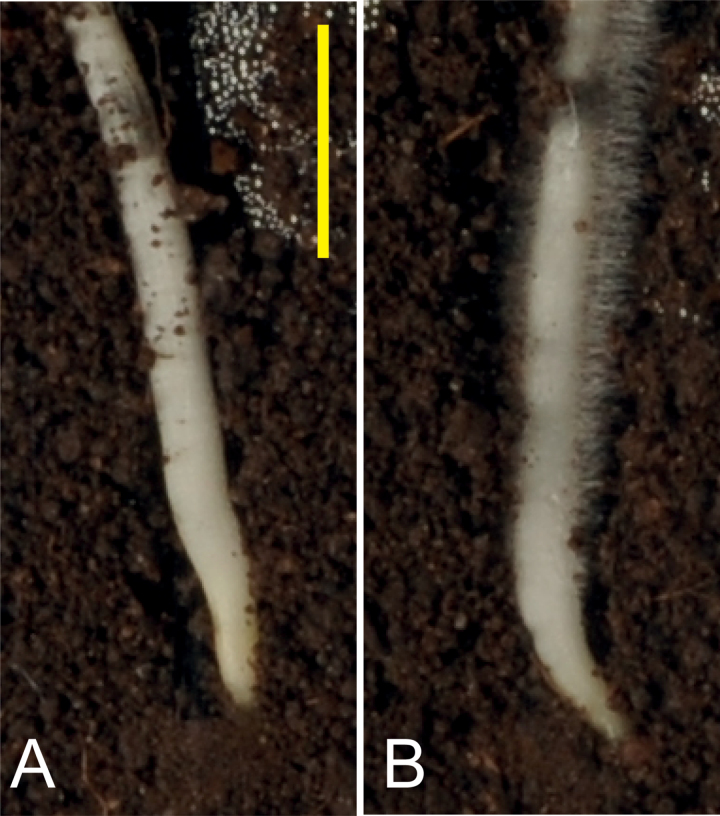
Wild-type (A) and hairless mutant (rth3–3; B) maize roots used in the experiments, growing from artificial bipore into soil of density 1.0g cm−3 (scale bar indicates 5mm).